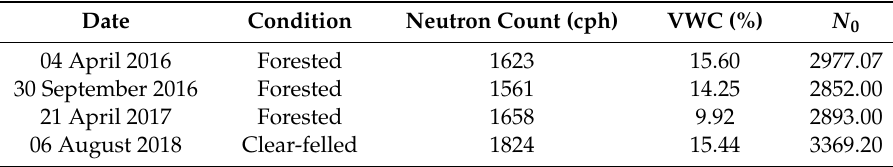
Table 2. Two-Streams Catchment calibration information.